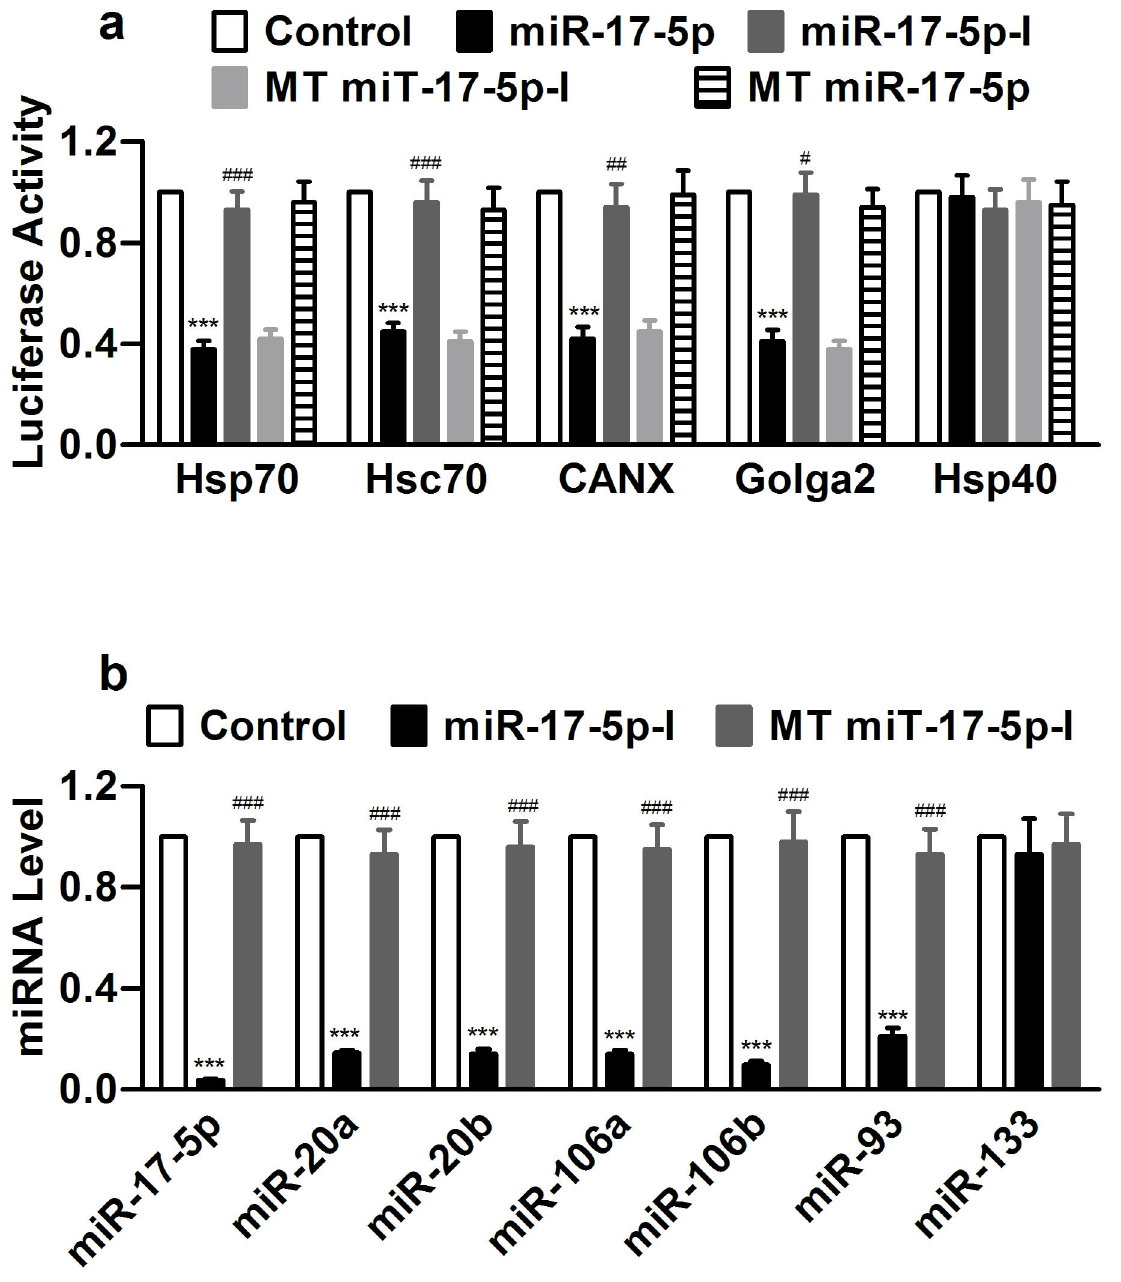
Figure 4. Experimental verification of Hsp70, Hsc70, CANX, and Golga2 as target genes of miR-17-5p by luciferase reporter gene activity assay in HEK293 cells. (a) Evaluation of effects of miR-17-5p on luciferase activities elicited by chimeric 3’UTR—luciferase vector to verify the interaction between miR-17-5p and the target sites of the ER stress-related chaperones. miR-17-5p-I: miR-17-5p inhibitor (co-transfected with miR-17-5p mimic); MT miR-17-5p: mutant miR-17-5p; MT miR-17-5p-I: mutant miR-17-5p inhibitor. Hsp40 was used as a negative control for the target chaperones, and MT miR-17-5p and MT miR-17-5p-I were used as negative controls for miR-17-5p. *** P <0.001 miR-17-5p vs Control; n=6; # P <0.05, ## P <0.01 & ### P <0.001 miR-17-5p-I vs miR-17-5p. (b) Real-time RT-PCR quantification to verify the efficacy of miR-17-5p-I to knock down miR-17-5p seed miRNAs. miR-133 was used as a negative control. *** P <0.001 miR-17-5p vs Control; n=6; # P <0.05, ## P <0.01 & ### P <0.001 miR-17-5p-I vs miR-17-5p.